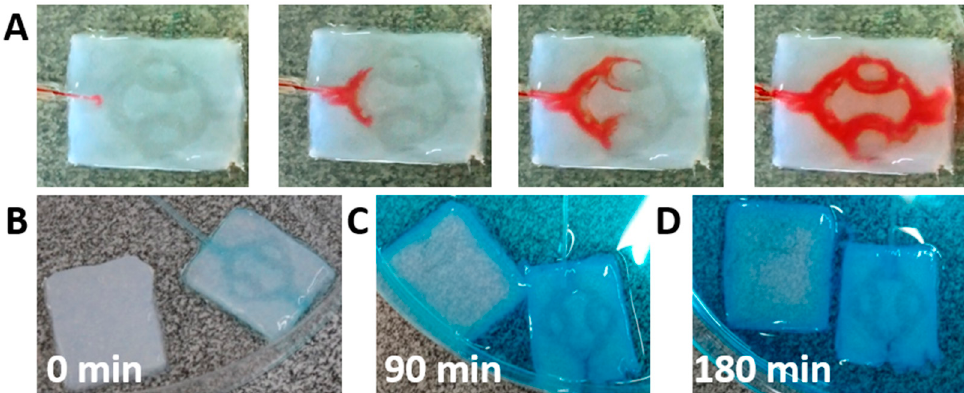
Figure 5. Perfusion and diffusion in the channeled hydrogel. ( A ) Fluid flow through the hydrogel channels. ( B ) Dye diffusion after 0 min, ( C ) after 90 min and ( D ) after 180 min in pristine-static and channeled-perfused samples.